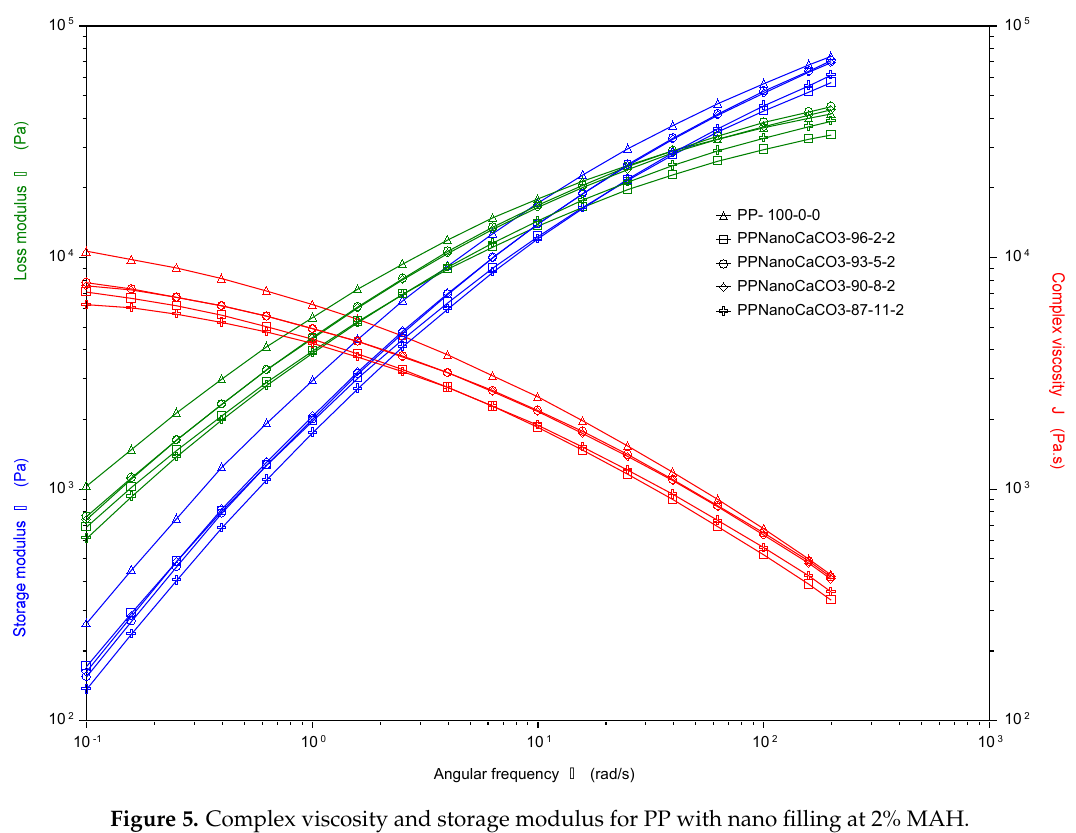
Figure 5. Complex viscosity and storage modulus for PP with nano filling at 2% MAH.